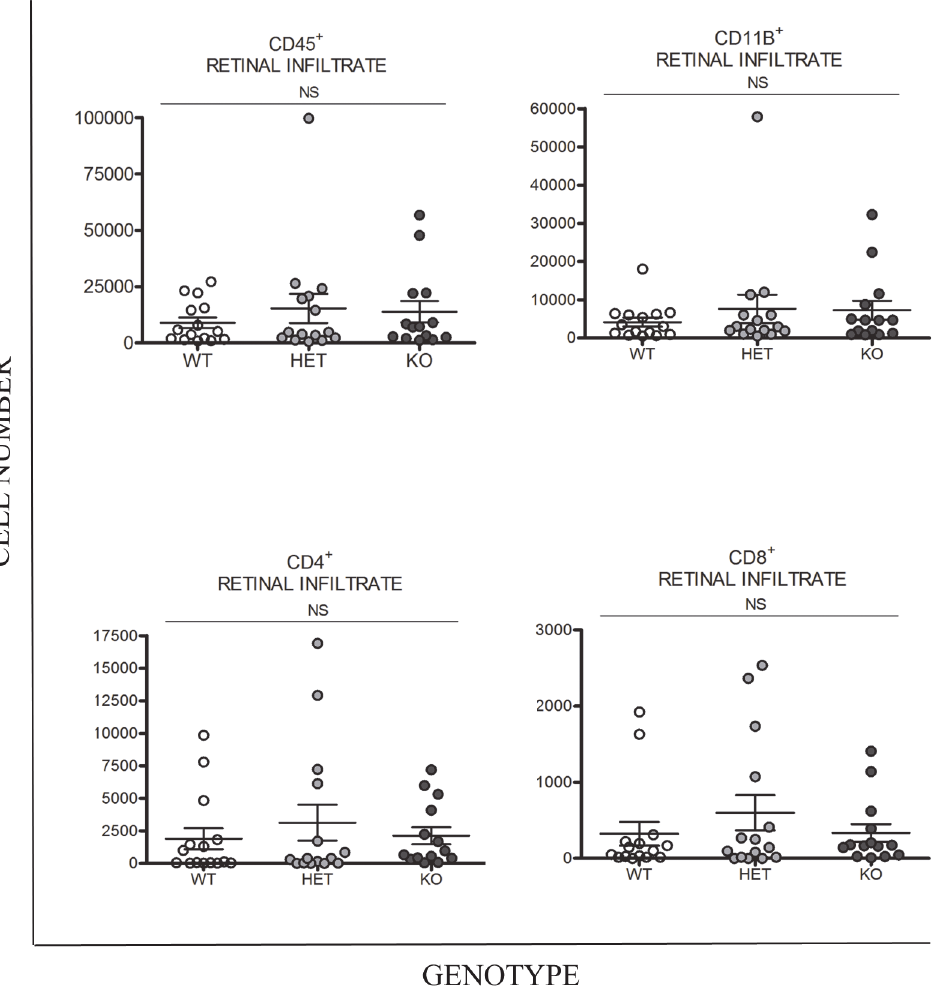
Fig 6. Quantification of retinal cellular infiltrate at day 26 post immunisation in a C57BL/6 murine model of EAU carrying Lp-PLA2 WT, heterozygous and homozygous gene-deletion genotypes. Flow cytometry data showing CD45 + , CD11b + , CD4 + and CD8 + cellular infiltrate in retinal digests from Lp-PLA 2 KO, HET, WT animals with EAU at day 26 post immunisation. (n = 14 – 15